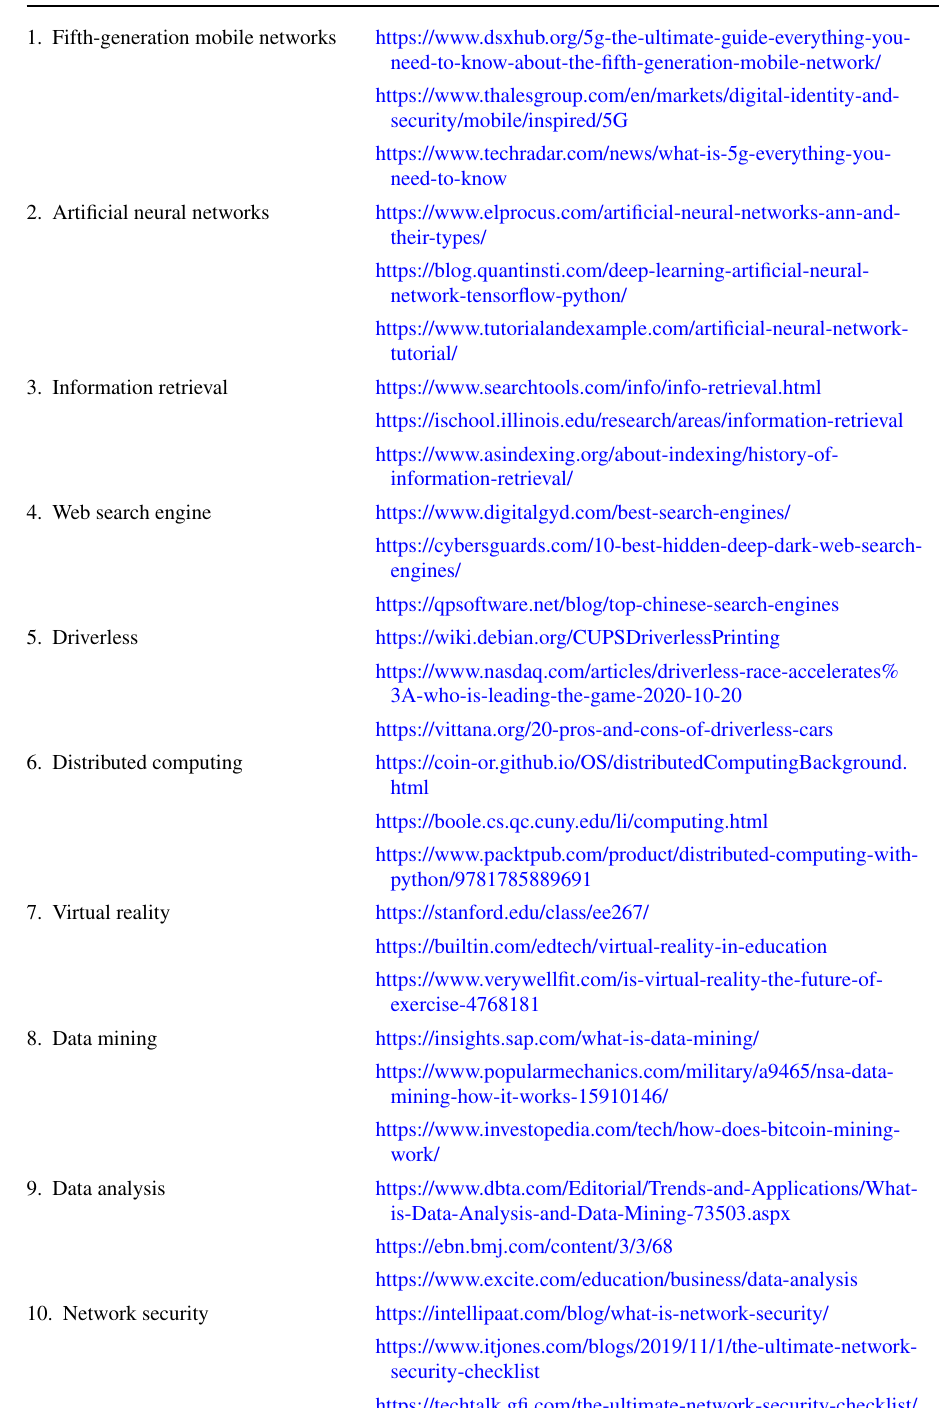
Table 3 The initial URLs for ten different